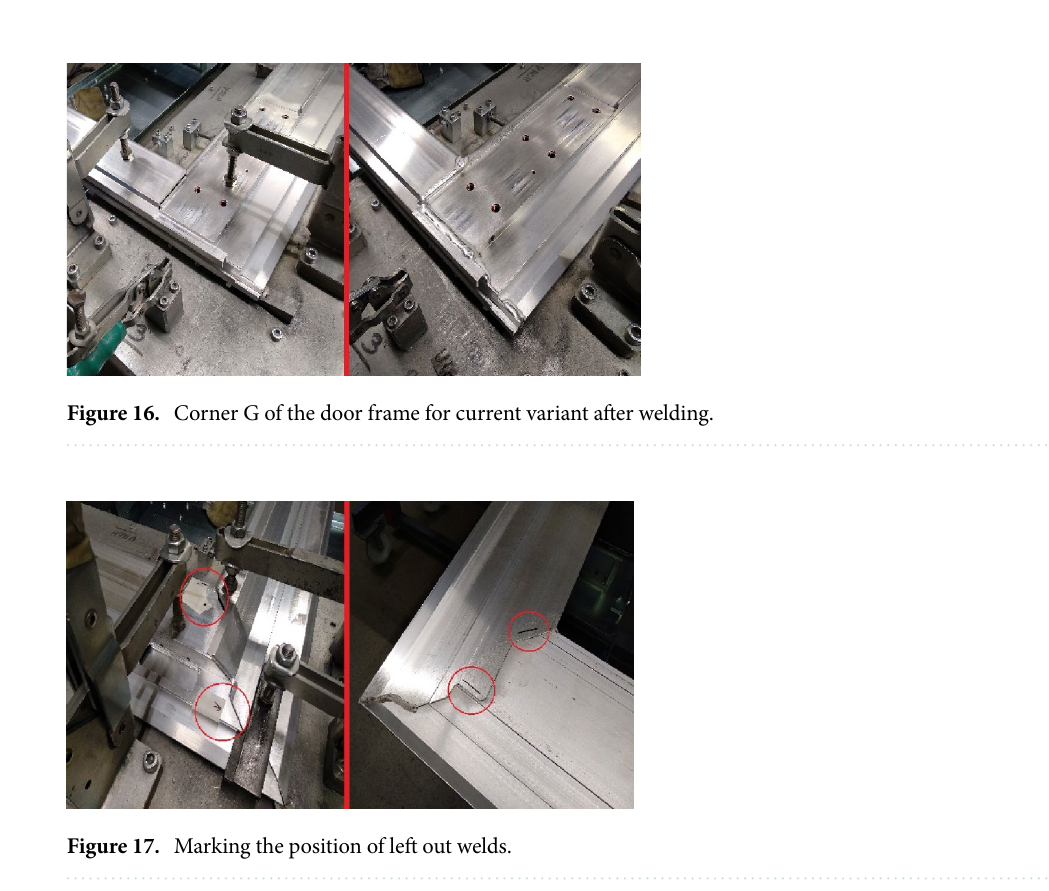
Figure 15. Tack welding of a door frame.